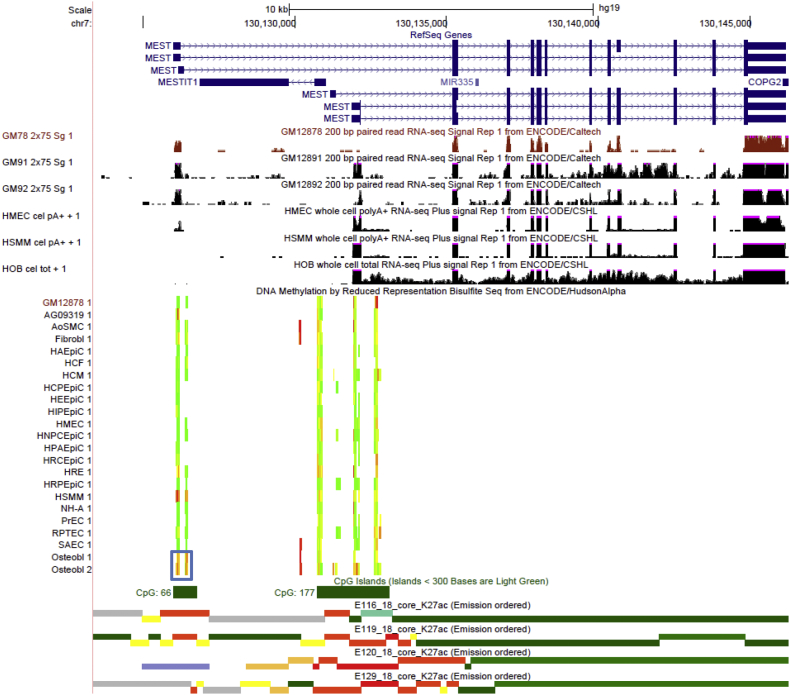
Osteoblastic hypermethylation at MEST gene region. The same tracks as illustrated in Fig. 3 are shown using the UCSC Genome Browser (http://genome.ucsc.edu, version hg19), with the additions of RNA-seq tracks for LCLs (GM12891 and GM12892) from ENCODE/Caltech. Osteoblast-specific DMR is highlighted in the blue box.